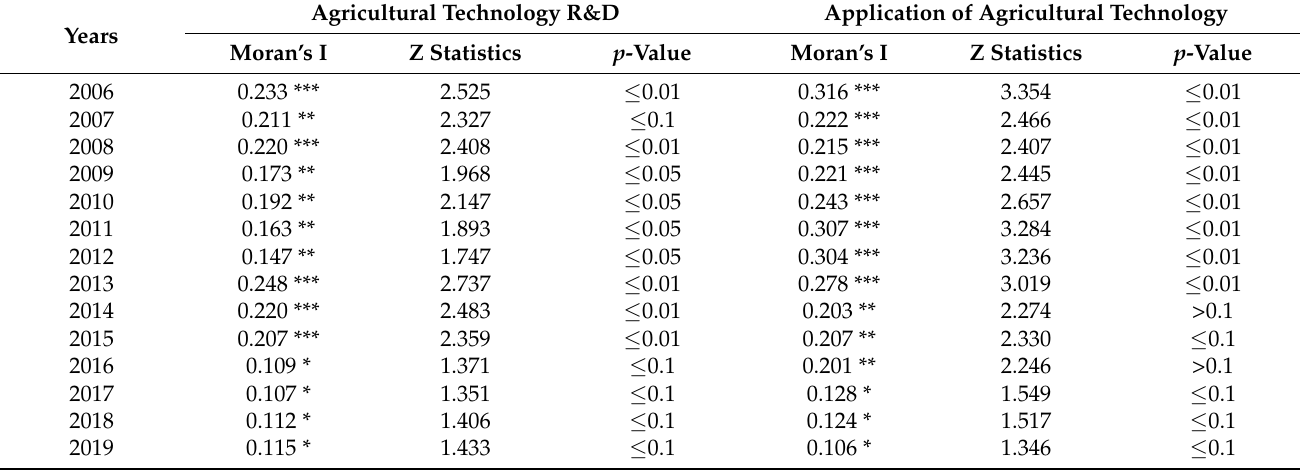
Table 5. Moran’s I test results of global Moran’s index for agricultural technology development and agricultural technology application.